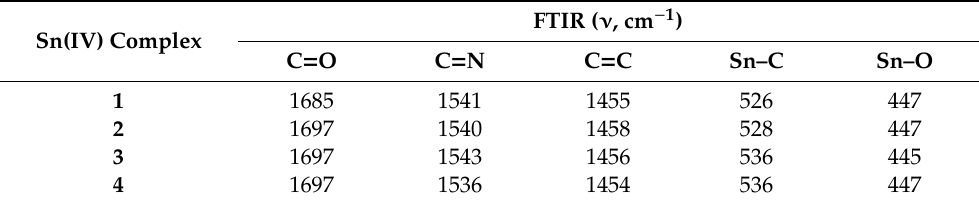
Table 2. Key FTIR spectral data of complexes 1–4 .